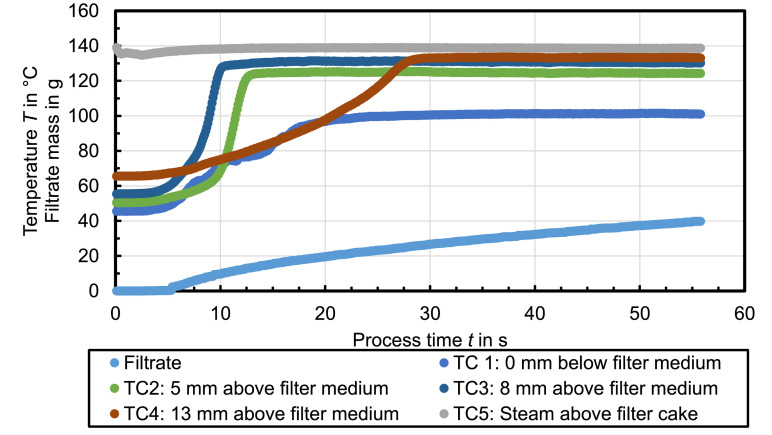
Celite®512 & n-dodecane (Δp = 2.7 bar, Tst = 140°C, hFC = 20 mm); RM = 35.1 %, rC = 1 × 1012 1/m²